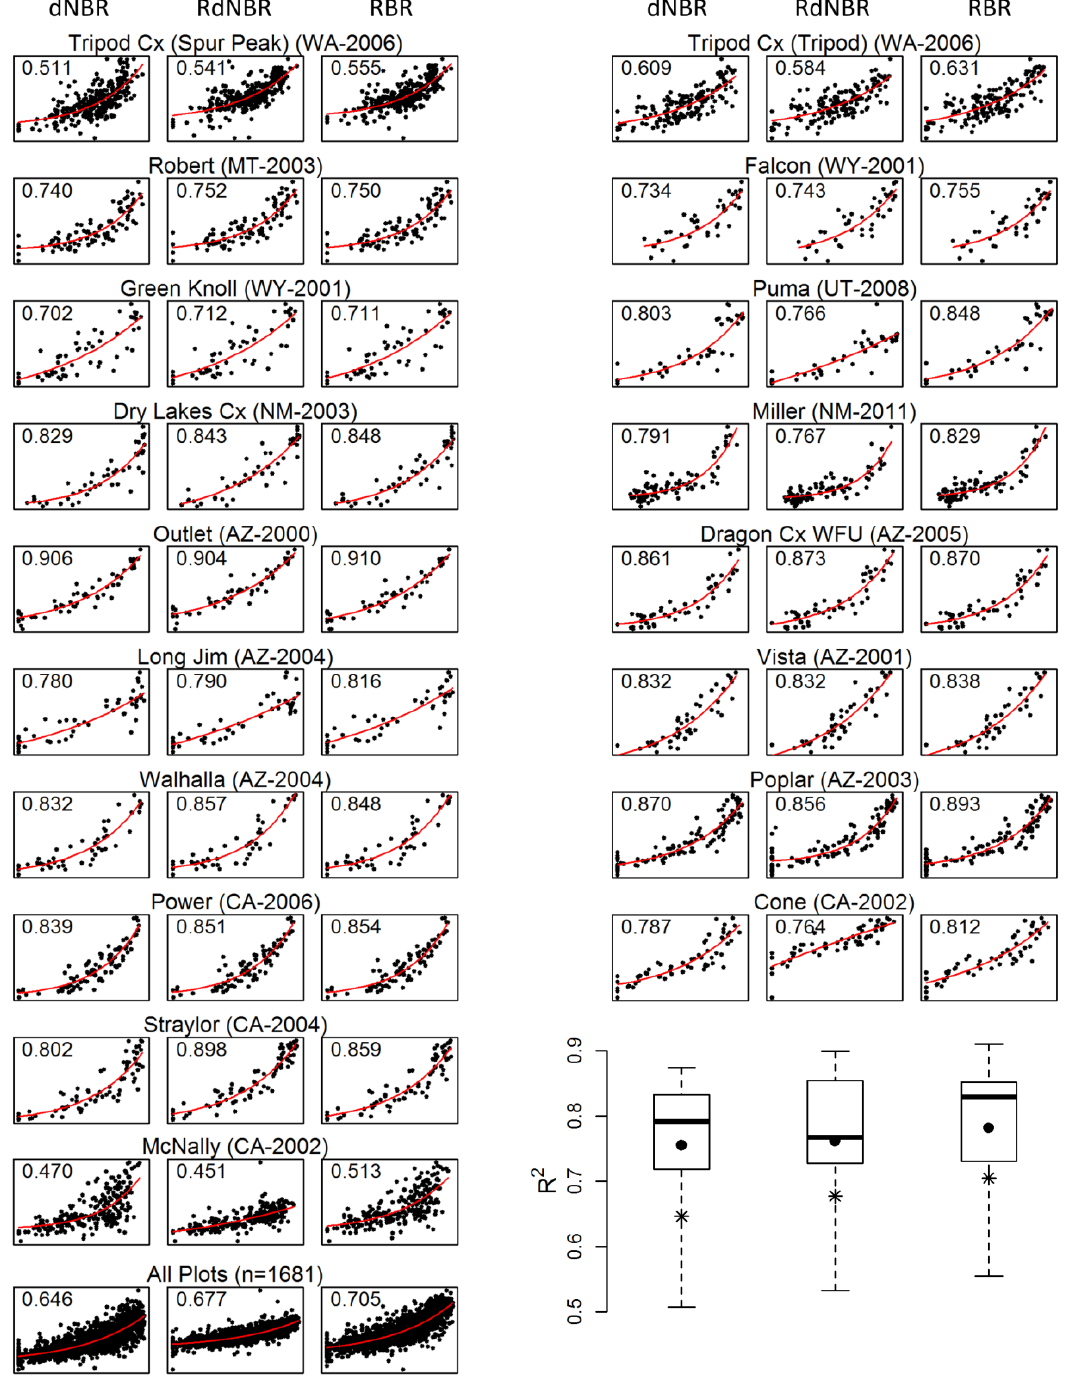
Figure 2. Scatterplots depicting the relationship between three remotely sensed severity metrics (y-axis) and composite burn index (CBI) (x-axis). The state abbreviation and year in which the fire occurred are shown in parentheses. The red lines represent the nonlinear fits. The coefficient of determination (R 2 ) is shown for each fit. Boxplots in the lower right summarize the R 2 of all fires for each metric; boxes represent the inter-quartile range, whiskers extend to the 5th and 95th percentiles, horizontal lines represent the median, solid dots the mean, and asterisks indicate the R 2 of 1681 plots with a single model. All fits are statistically significant (p <